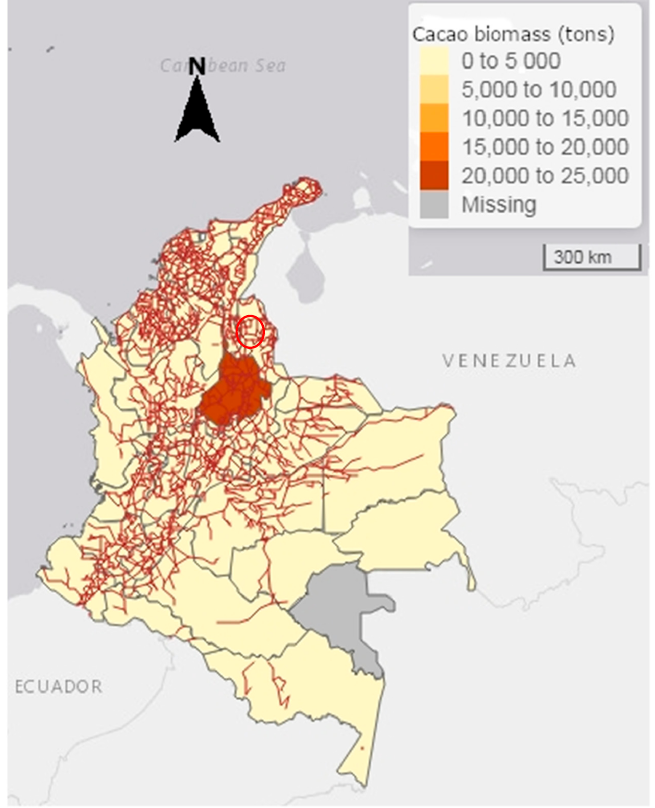
Figure 2. Colombia map representing cacao waste biomass (CPH) in tons based on 2019 beans production and the transport network (red lines). The red circle highlights the Caldas region.